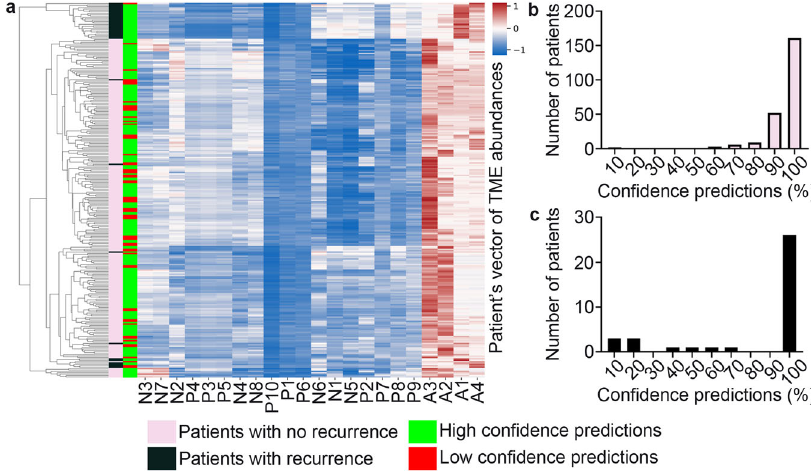
Fig. 8 Analysis of prediction con fi dence. a Heatmap showing the “ prototypical ” spatial features of the tumor microenvironmental elements (TME) at three levels: local phenotypes (P1 – 10), cellular neighborhoods (N1 – 8), and tissue areas (A1 – 4) in tumors with recurrence and tumor with no recurrence. High and low-con fi dence predictions are shown. b , c The overall con fi dence predictions of NaroNet for all 250 patients is shown. The vast majority of patients show high con fi dence predictions (>0.90). Patients with low-con fi dence predictions (<0.50) were misclassi fi information to make the fi nal predictions of tumor recurrence. tissues: (i) local phenotypes (one single cell or interactions between Each level of interaction and feature in the deep learning framework is fully interpreted using graphs, heatmaps, and direct areas. These features are of high biologic relevance and combine visualization in the tissue.